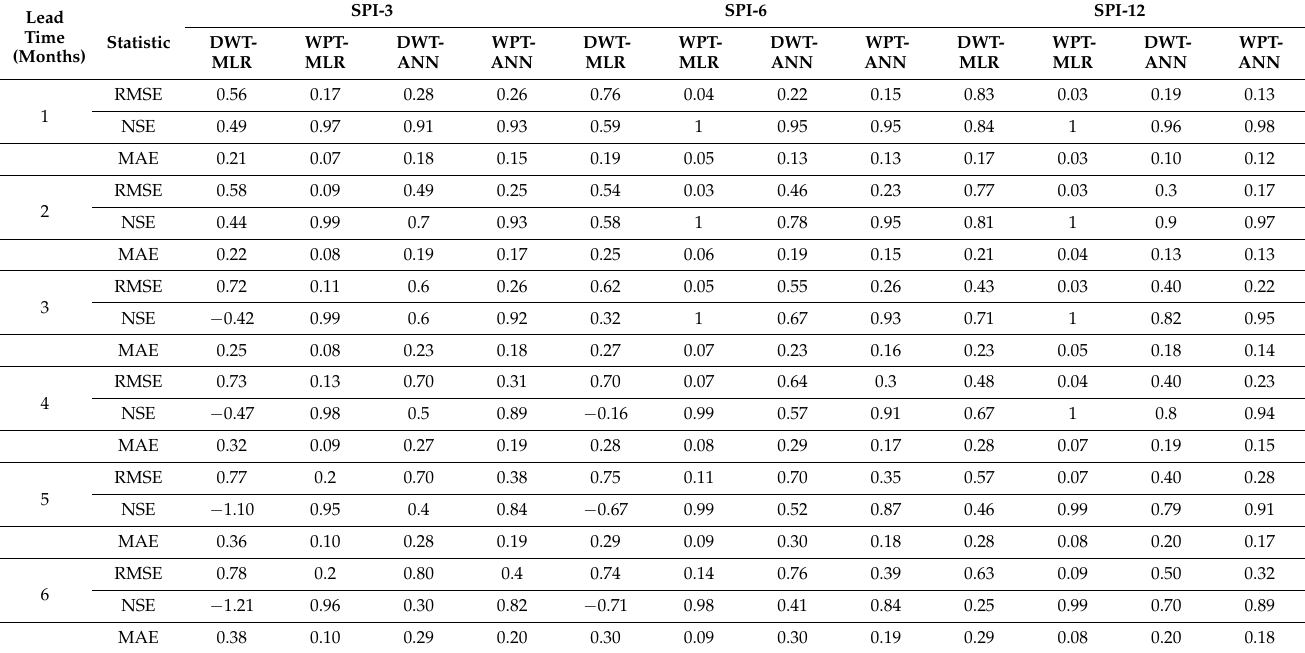
Table 5. Performance of hybrid